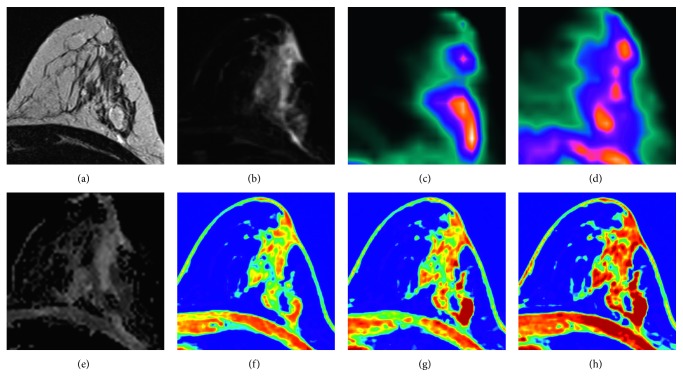
46-year-old patient with hormone receptor positive/Her2 negative invasive ductal carcinoma in the left breast. Multiparametric [18F]FDG/[18F]FMISO PET-MRI : cancer presented as a segmental heterogenous persistently enhancing nonmass enhancement. (f–h) DCEnative, DCEearly, and DCEdelayed with perifocal edema. (a) T2-weighted without fat saturation. (b) T2-weighted with fat saturation. The lesion showed moderate uptake of (c) [18F]FDG (SUVmax = 6.5) and (d) [18F]FMISO (SUVmax = 1.3) with restricted diffusion visualized on the ADC map (e).